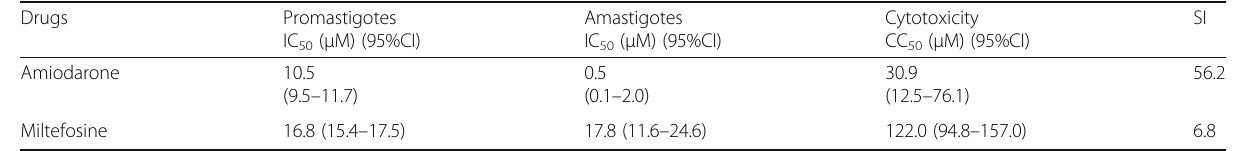
Table 1 In vitro IC 50 against promastigotes and amastigotes of Leishmania , CC 50 against NCTC cells and SI Drugs